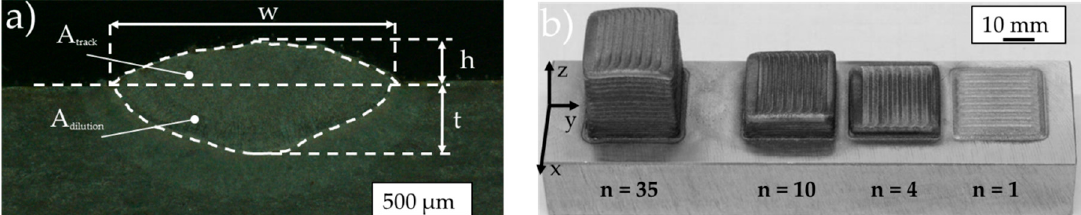
Figure 5. ( a ) Etched cross section of a single weld track ( P = 1 kW, (cid:1865)(cid:4662) = 3.7 g/min (cid:4667) and ( b ) cuboidal samples made out of AISI H11 with 0.2 wt. % additional carbon nanoparticles with varying numbers n of deposited weld track layers ( P = 800 W, (cid:1865)(cid:4662) = 3.7 g/min , f rate = 400 mm/min).